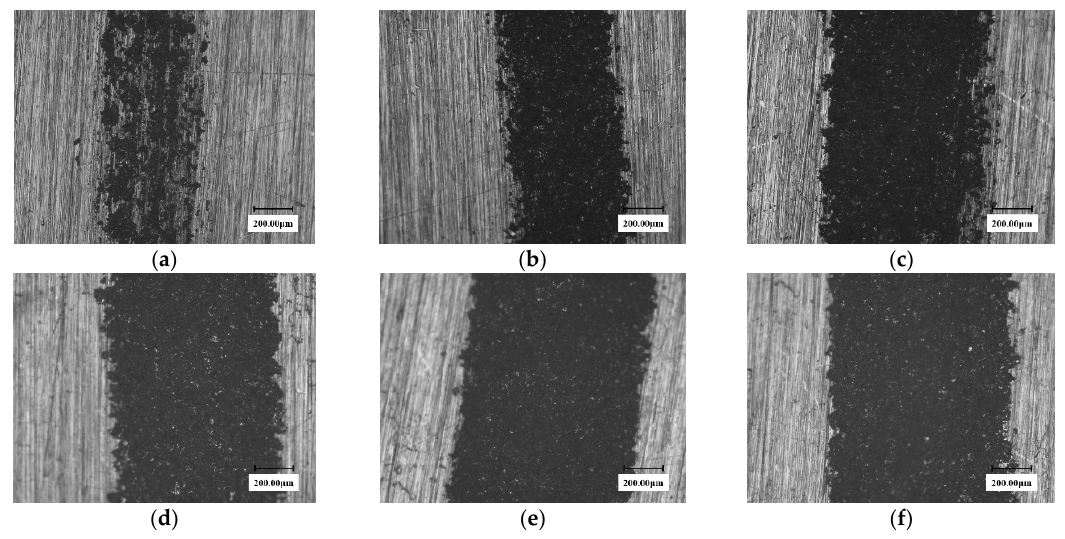
Figure 4. The Surface microscopic morphology of 90° solid solution reinforced samples at different times. (nozzle diameter: 0.2 mm). ( a ) 60 min; ( b ) 120 min; ( c ) 150 min; ( d ) 270 min; ( e ) 330 min; ( f ) 390 min.